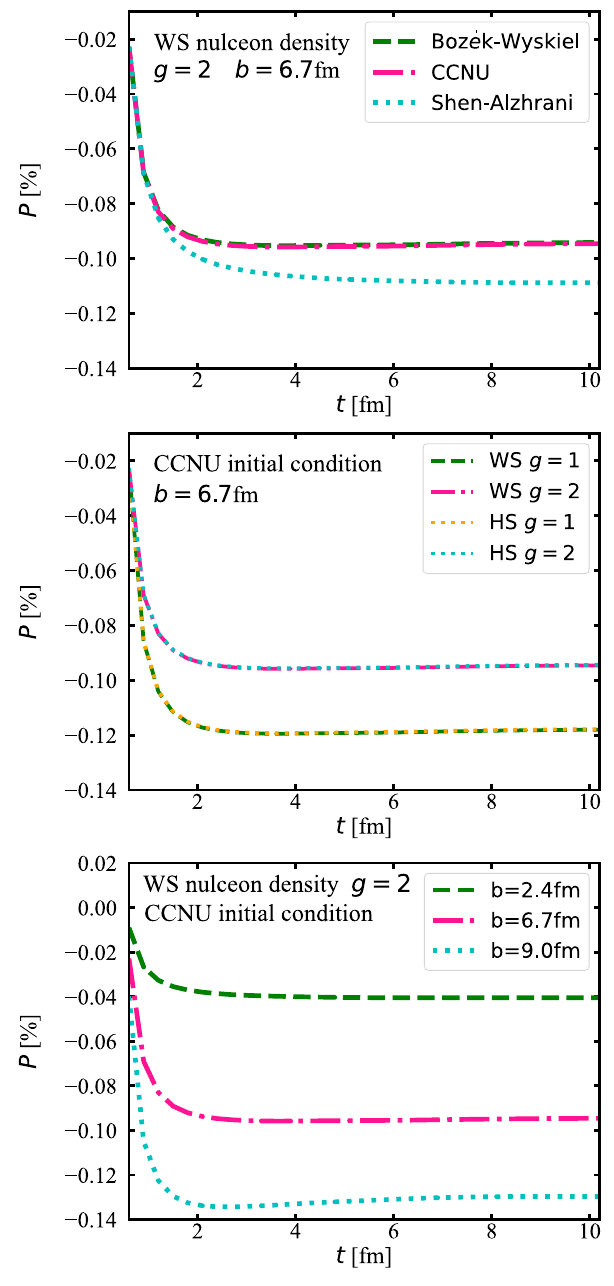
Fig. 11 Time evolution of the transverse-plane-averaged polarization, compared between using different initial conditions for the hydrody- namic evolution (upper panel), different density functions of the initial nucleon distribution and different values of g (middle panel), and dif- ferent impact parameters (lower